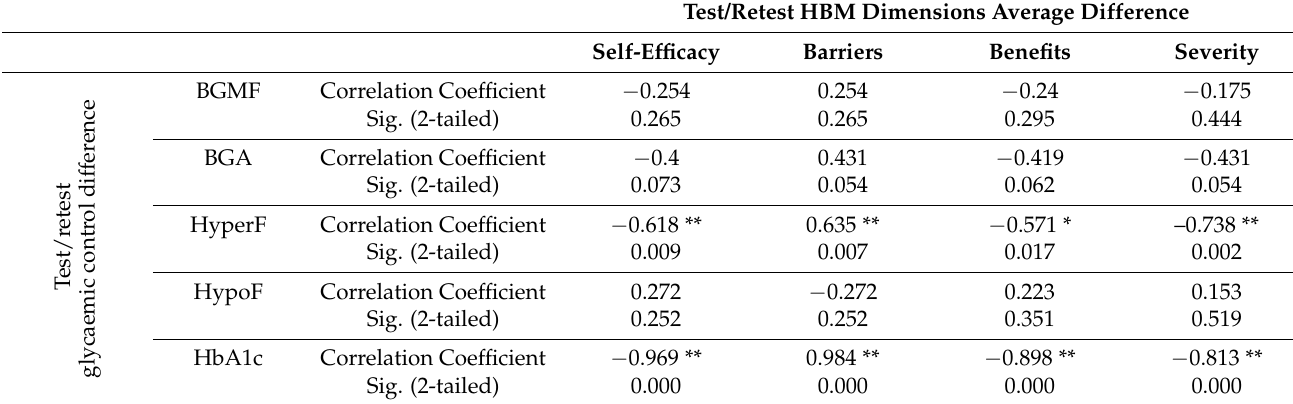
Table 5. Kendall’s Tau-b correlation coefficient for Health Belief Model (HBM) dimensions and glycaemic